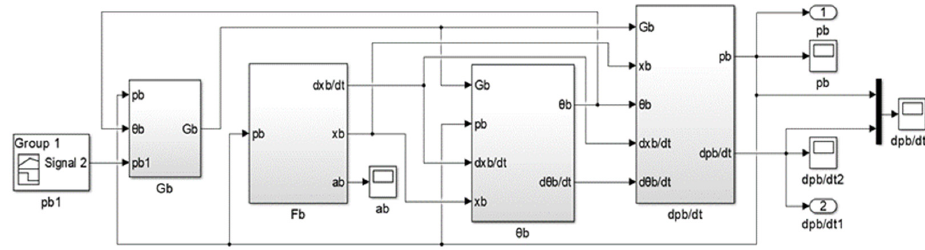
Figure 4. Simulation model of the brake chamber inflation process.